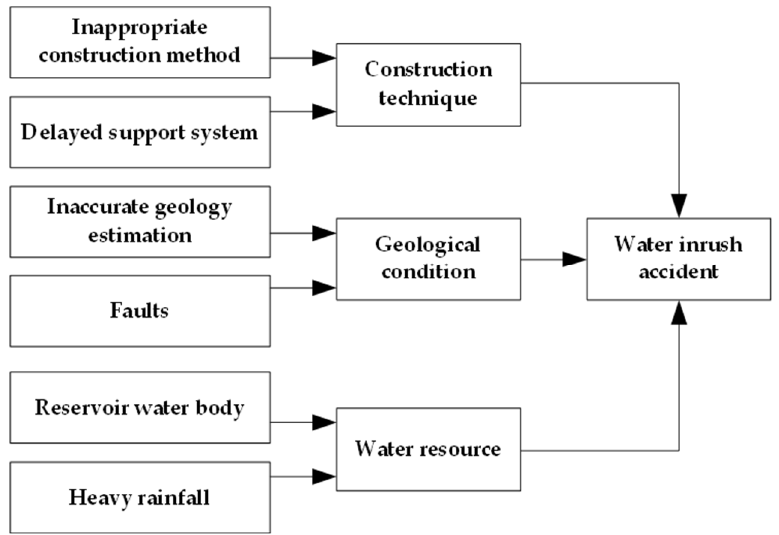
Figure 9. Triggering factors of water inrush accident.